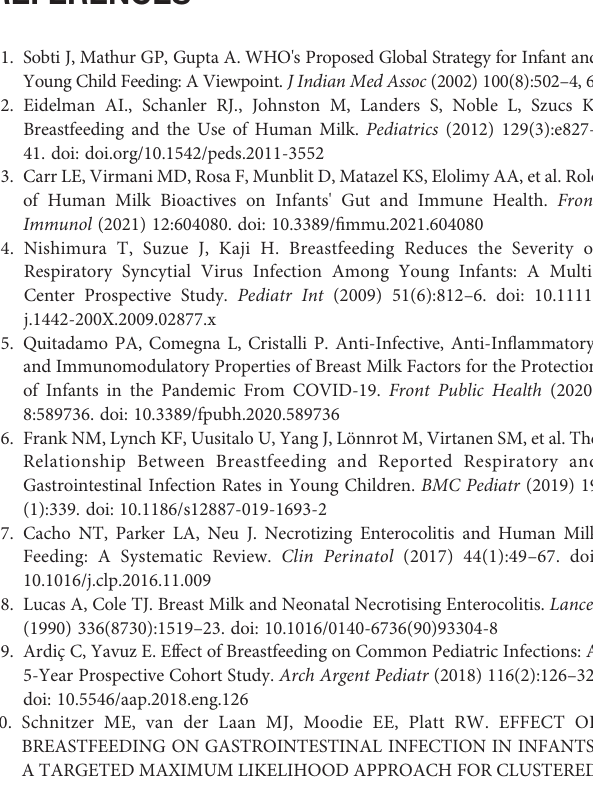
Supplementary Figure 2 | Violin plots of variance partition analysis for all experimentalfactorsanalyzedin (A) smallintestine(SI)and (B) largeintestine(LI)samples. Supplementary Figure 3 | Expression pro fi le of gene clusters obtained from model-based analysis of highly variable genes in small intestine samples. For each condition, shown are barplots representative of at least fi ve biological replicates. The number of genes classi fi ed in each cluster is displayed on top. Supplementary Figure 4 | Expression pro fi le of gene clusters obtained from model-based analysis of highly variable genes in LI samples. For each condition, shown are barplots representative of at least fi ve biological replicates. The number of genes classi fi ed in each cluster is displayed on top.